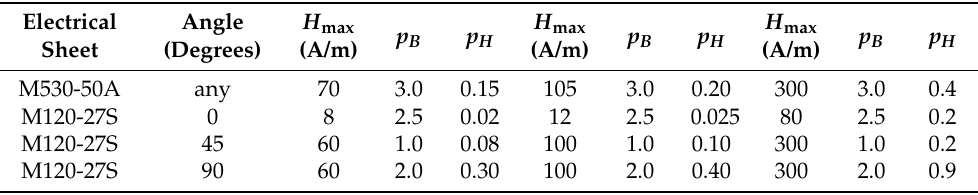
Table 1. Values of parameters p B and p H